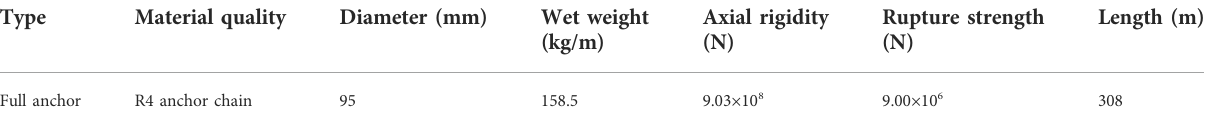
TABLE 2 Practical parameters of full anchor chain scheme.